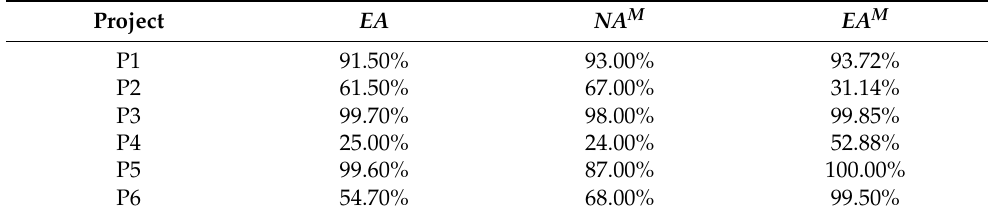
Table 4. Results of verification of the effectiveness of the classification of tasks and subtasks of